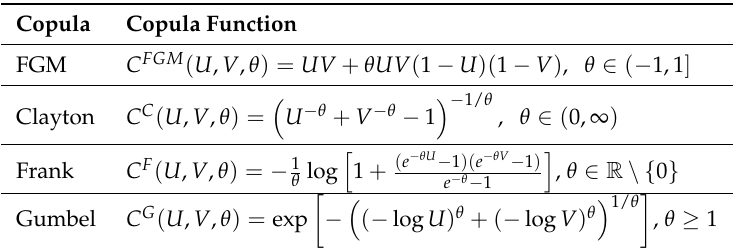
Table 1. Archimedean copula